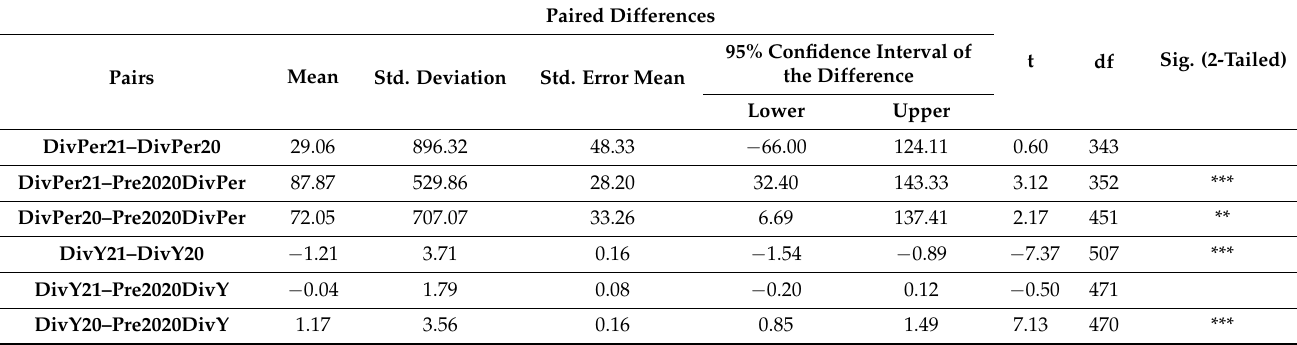
Table 2. Results of paired sample t-test of dividend payouts and dividend yield for the years 2021, 2020 vis- à -vis pre 2020. Pairs Mean Std. Deviation Std. Error Mean